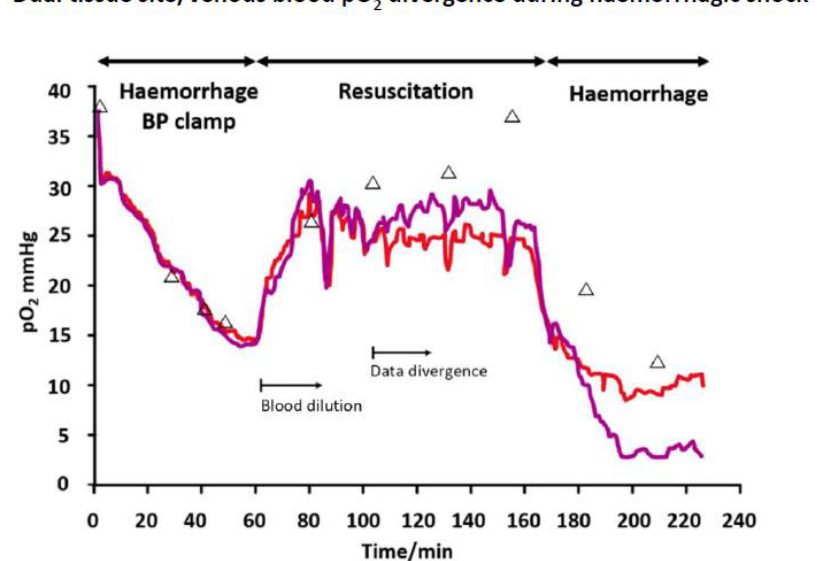
Figure 5. Tissue pO 2 changes monitored in single rat during haemorrhagic shock. Sensors at matched implantation sites in flank. Initial haemorrhage clamped at reduced BP (40 mmHg); saline only resuscitation stabilises BP (60–70 mmHg); haemorrhage to exsanguination with extreme, terminal drop in BP. Resuscitation regimen would lead to cumulative blood dilution, progressively lowering oxygen carrying capacity to peripheral tissue. Adapted from [52].